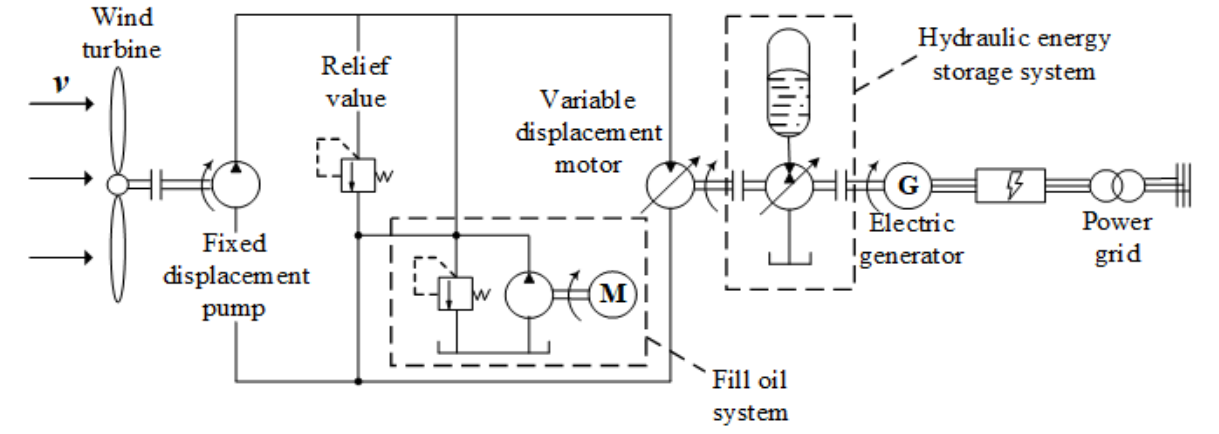
Figure 1. Diagram of the principle of operation of the hydraulic system for HWT.